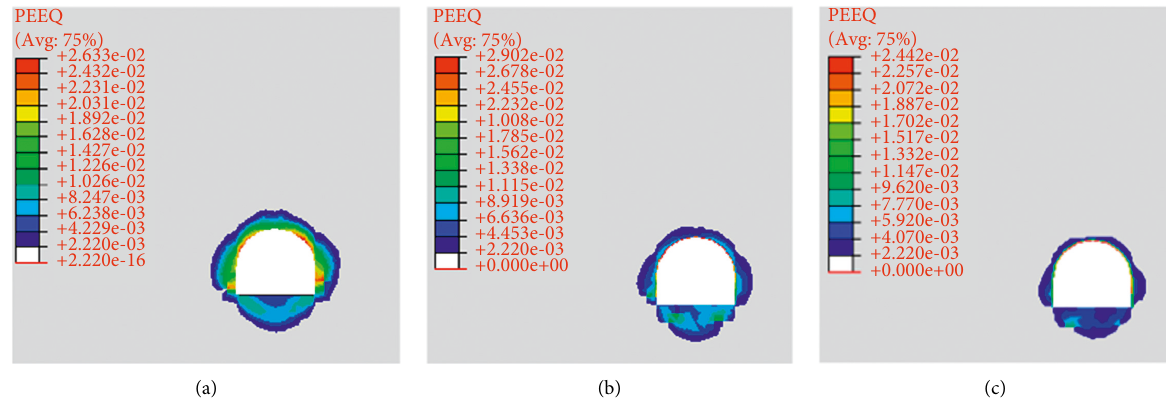
Figure 5: Plastic zone distribution of surrounding rock under different conditions: (a) case 1, (b) case 2, and (c)